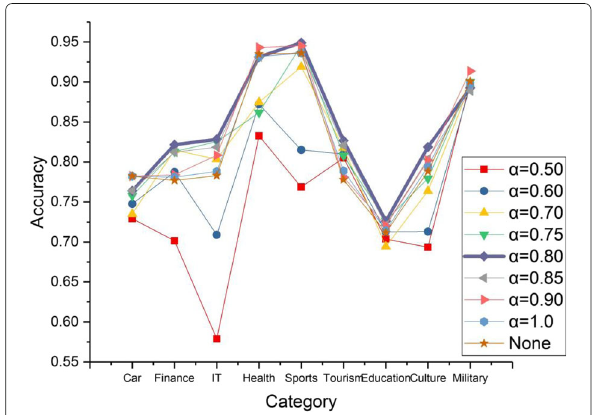
Fig. 4 F1 score of each category when α takes different values method introduced in Section 3.3. We designed three experiments, all with the first improved CHI formula and a threshold of 0.8. The experimental results are shown in Fig. 6: According to Fig. 6, it can be seen that the classification accuracy of method 1 is the lowest. The reason is that this method adds the weights of all the synonymy words as the weight of the feature, but a word and its synonym words appear in more than one category. This simple superposi- tion will make the feature differentiate the category worse.